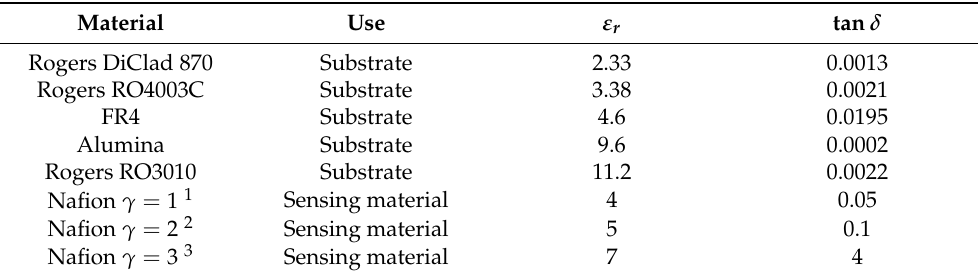
Table 2. Dielectric parameters used in the simulation for substrates (from the Datasheets) and sensing material (from [9,36]). The parameters for the sensing material are reported for three different humid- ity values. 1 Roughly corresponding to 0.3% relative humidity (RH) [9]. 2 Roughly corresponding to 3% RH [9]. 3 Roughly corresponding to 33% RH [36].